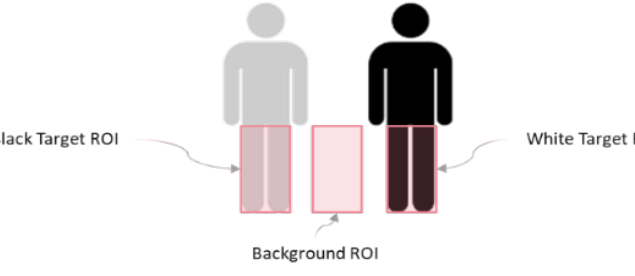
Figure 11. The concept of setting ROIs for analysis.